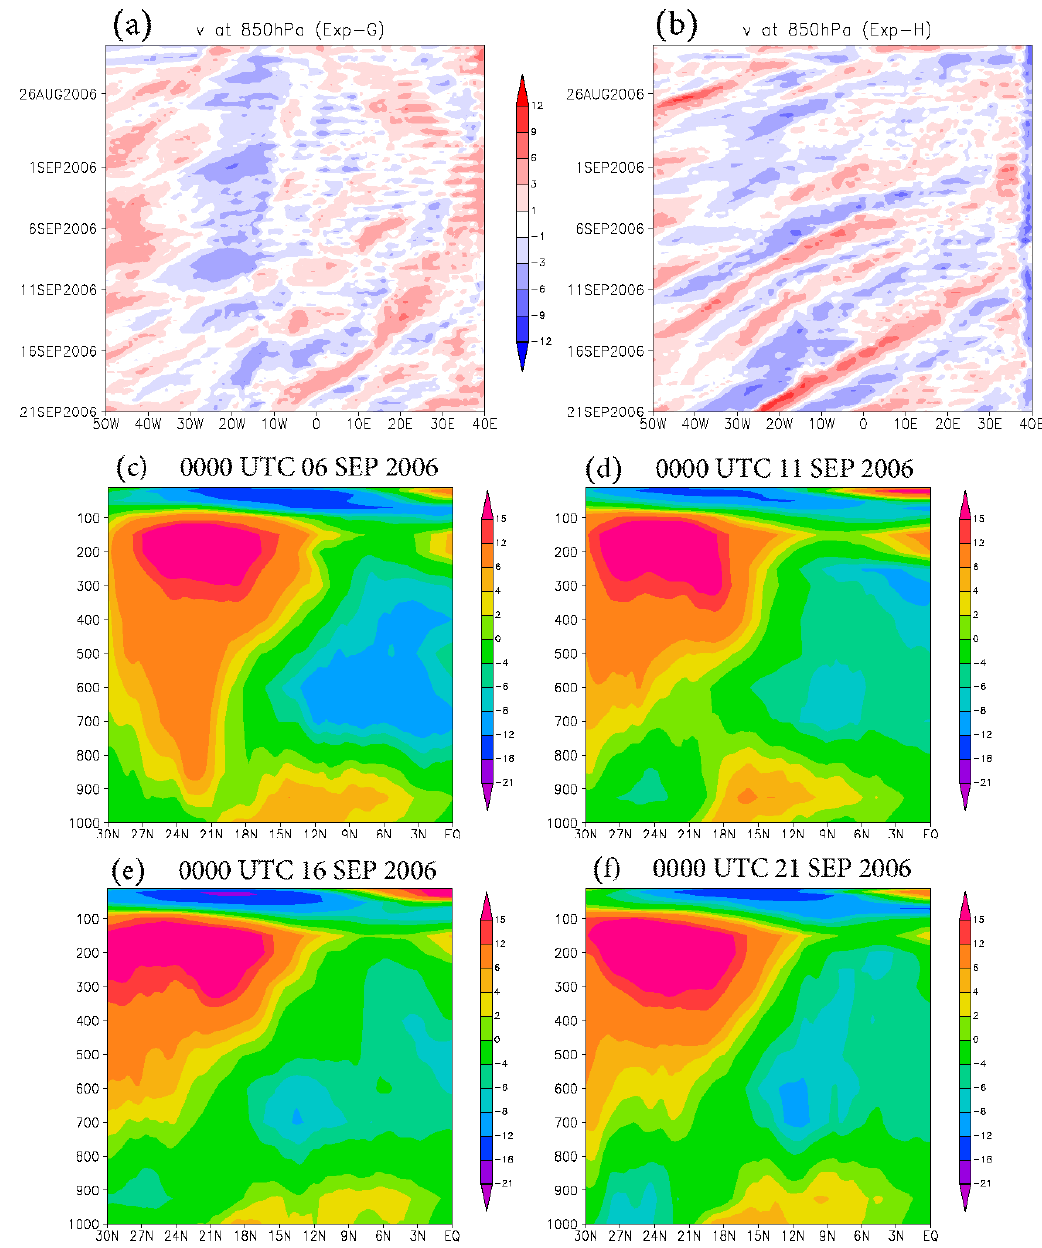
Figure 11. Panels ( a )-( b ) illustrate the sensitivity of AEW simulations to different dynamic ICs in experiments P1 and P2, respectively. Time-longitude diagrams of simulated meridional winds are plotted. Panels ( c ) – ( f ) display altitude – latitude cross sections of zonal winds averaged over longitude 20° W to 20° E on 6, 11, 16, and 21 September 2006, respectively, showing the development of an AEJ after 25 days in experiment P1. Data are from the supplemental materials in [6].